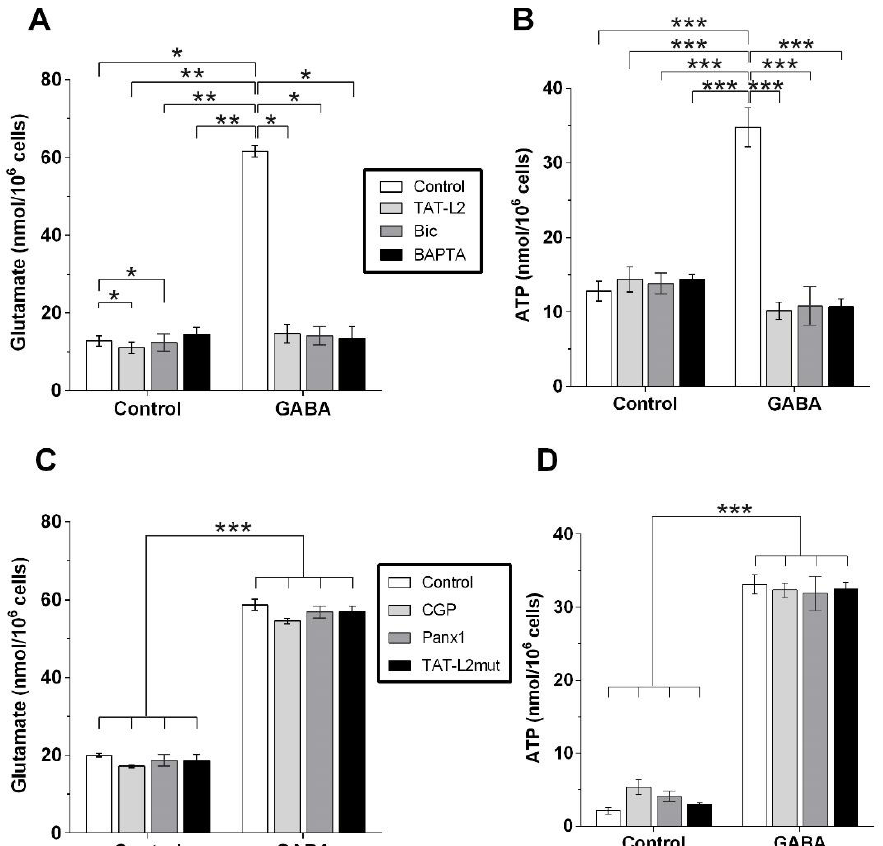
Figure 4. GABA induces the release of glutamate and ATP from DI TNC1 astrocytes, mediated by astroglial Cx43 hemichannels and the activation of GABA A receptors. ( A ) The extracellular glutamate concentration was determined after incubation with 1 µ M GABA alone (GABA) or after preincubation with 100 µ M bicuculline (Bic), 10 nM TAT-Cx43L2 (TAT-L2) or 100 nM BAPTA-AM (BAPTA). ( B ) Extracellular ATP concentration was determined after incubation with 1 µ M GABA alone or preincubated with 100 µ M bicuculline (Bic), 10 nM TAT-Cx43L2 (TAT-L2) or 100 nM BAPTA-AM (BAPTA). ( C ) Extracellular glutamate concentration was determined after incubation with 1 µ M GABA alone or preincubated with 1 µ M CGP55845 (CGP), 10 nM mutant TAT-Cx43L2 (TAT-L2mut) or 150 nM 10 Panx1 (Panx1). ( D ) Extracellular ATP concentration was determined after incubation with 1 µ M GABA alone or preincubated with 1 µ M CGP55845 (CGP), 10 nM mutant TAT-Cx43L2 (TAT-L2mut) or 10 Panx1 (Panx1). n = 3, with technical triplicates. Error bars: SE; * p ˂ 0.05, ** p ˂ 0.01, *** p ˂ 0.001.